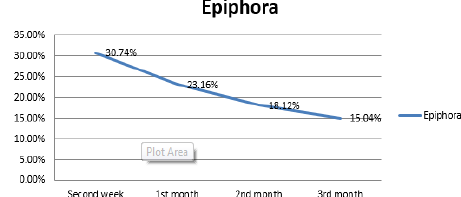
Fig 1. Clinical Success Rate and Distribution of Tearing at Follow-up after the